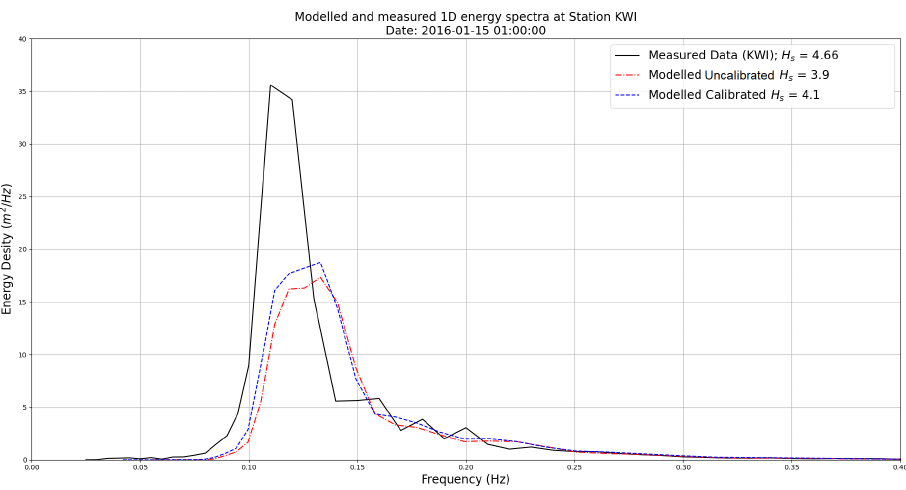
Figure 11. Spectral comparison for the Kwintebank station on 15 January 2016 01:00 showing the uncalibrated and calibrated SWAN models forced with